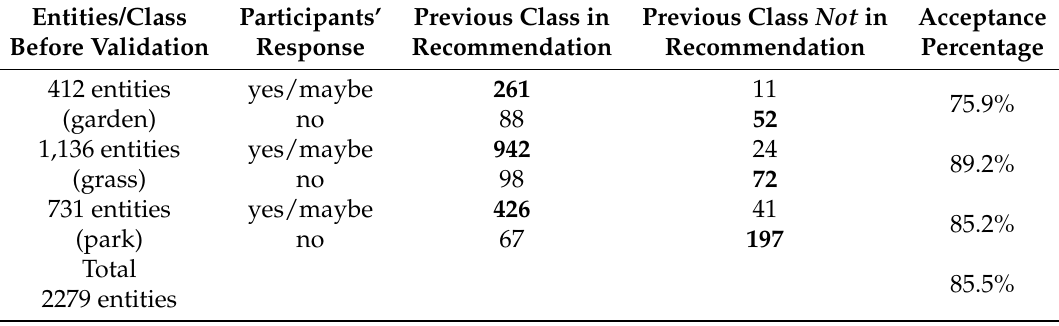
Table 2. Entities classified before and after the validation with respect to the recommended classes and participant opinions.